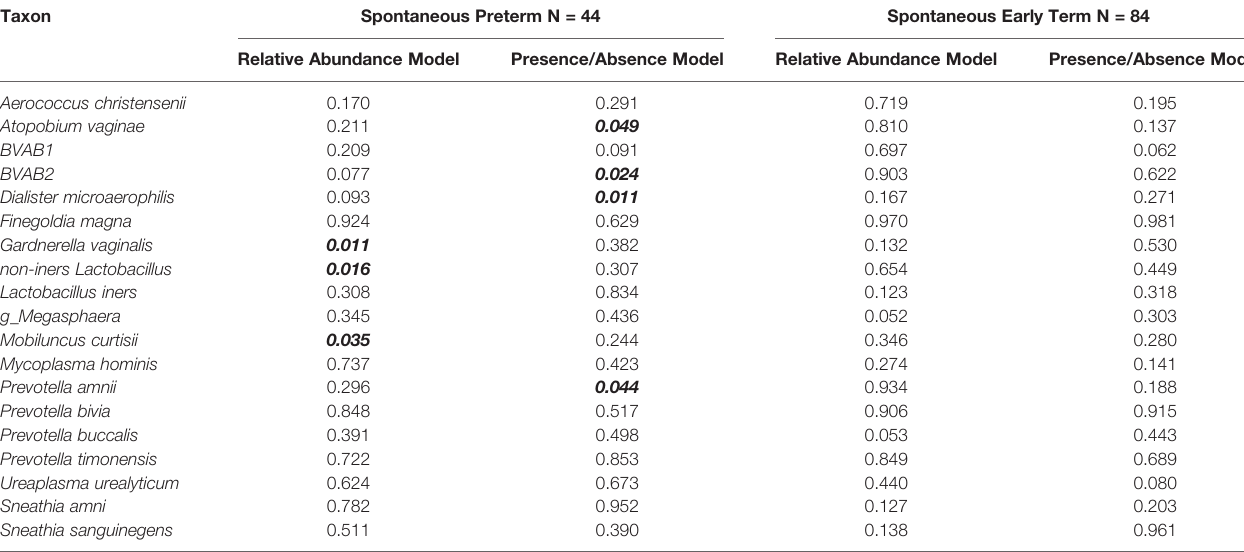
TABLE 7 | Raw p-values for Pre-speci fi c Taxa in the LDM Model 1 for Spontaneous Preterm Birth and Spontaneous Early Term Birth. Taxon